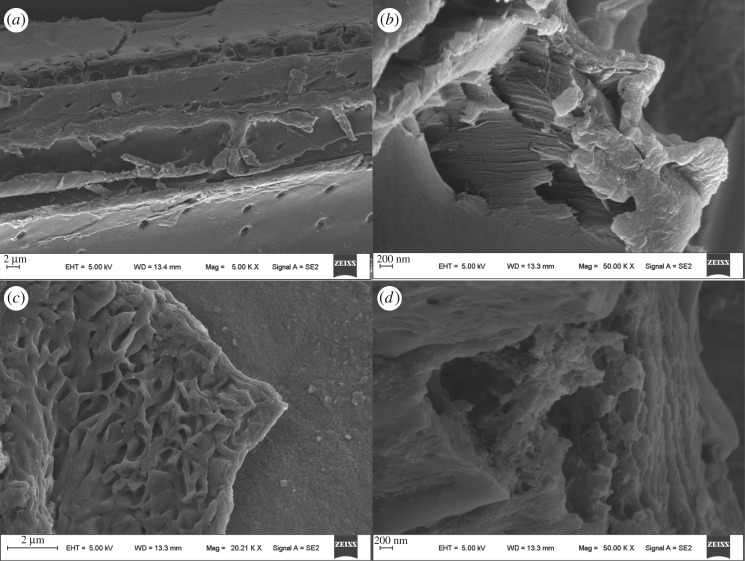
Scanning electron microscopy of MS (a,b), and SAPs (c,d).